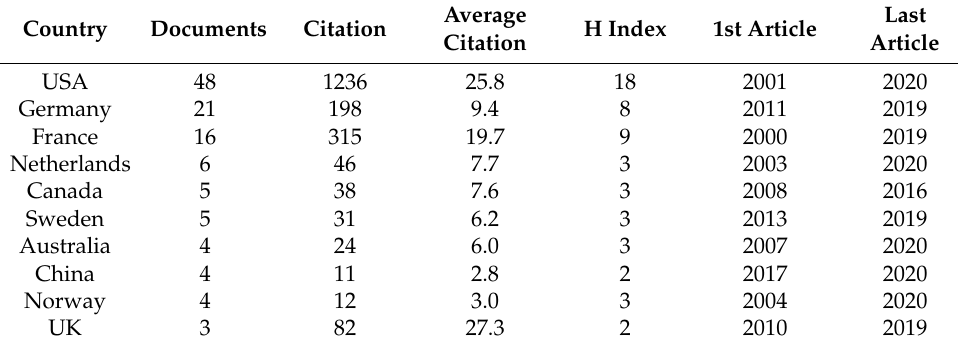
Table 4. Main characteristics of the most active countries related to EEA